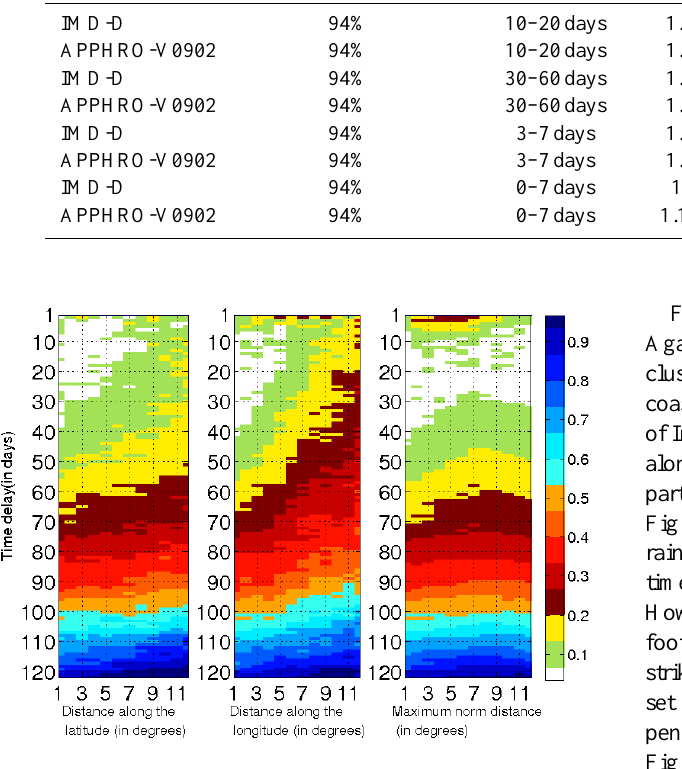
used to generate above image is IMD-D. generate above image is